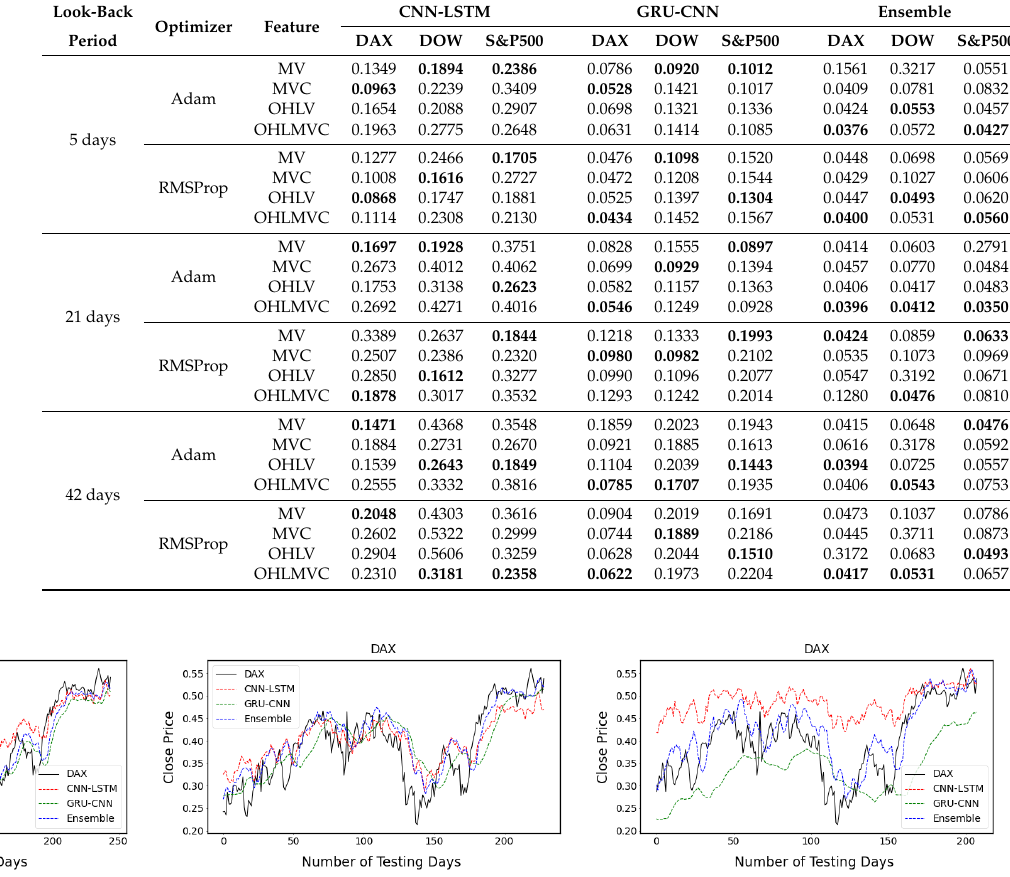
Table 8. Comparison of different optimizers and features in terms of average MAE over the three periods for five-time-step prediction.